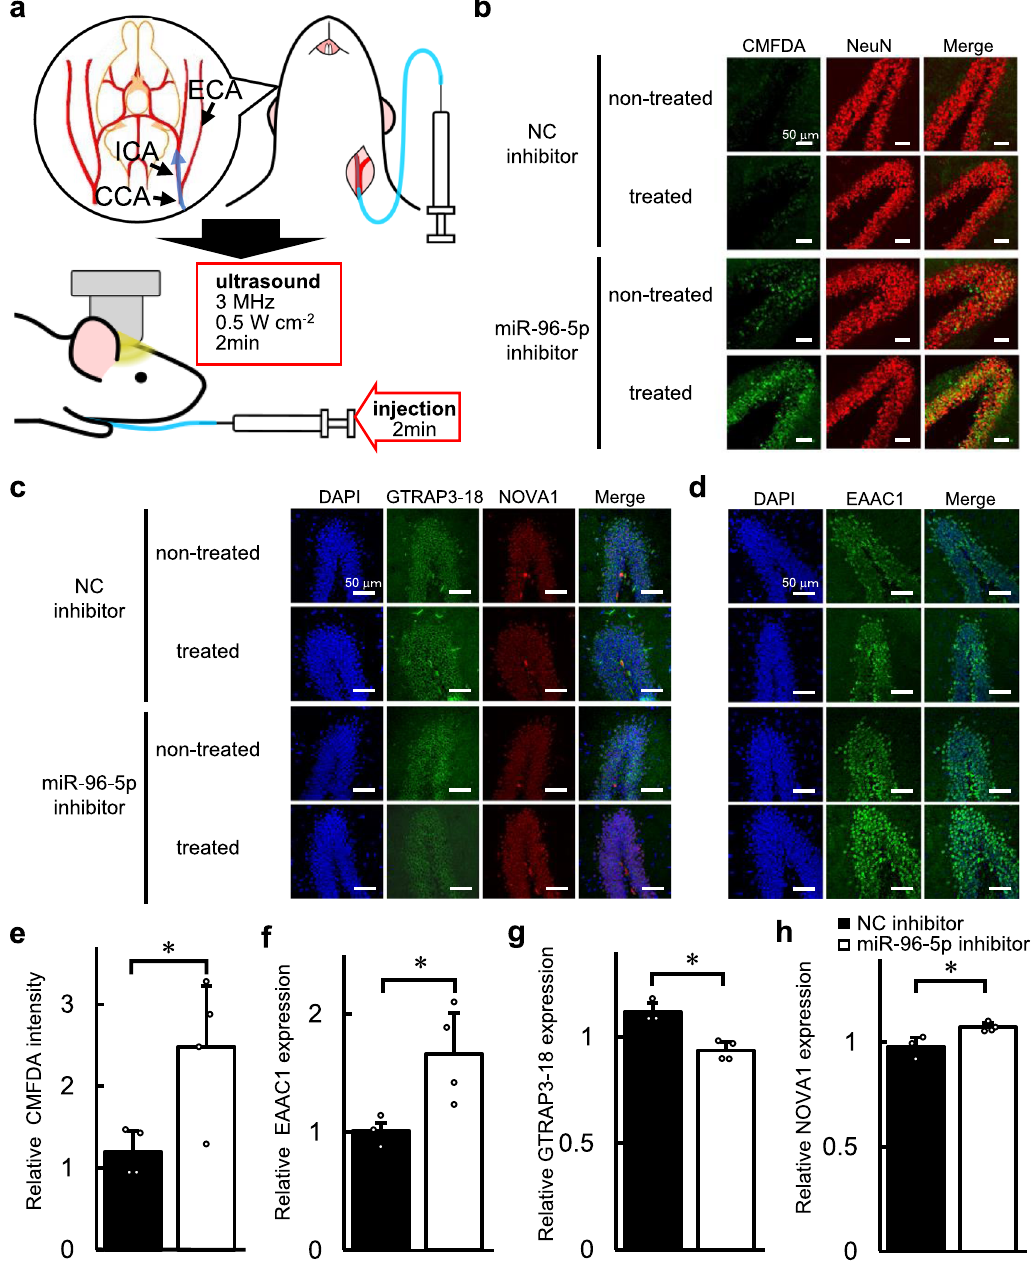
Fig. 5 Effect of the intra-arterial administration of miR-96-5p inhibitor with MBs and US on the levels of GSH, EAAC1, GTRAP3-18, and NOVA1. a A schematic of the intra-arterial (i.a.) injection is shown. The common carotid artery (CCA), external carotid artery (ECA), and internal carotid artery (ICA) are exposed, and a small incision is made on the CCA. The catheter is inserted and advanced towards the ICA; once the catheter is stably positioned, a mixture of miR-96-5p inhibitor and MBs is injected with a programmed microinjector. Simultaneously with the injection, ultrasound (US) is administered from a probe placed on the shaved heads of the mice. b Confocal images show the effect of administration of a miR-96-5p inhibitor or a negative control (NC) inhibitor on the intensity of CMFDA as an intracellular GSH marker (green). NeuN is stained as a neuronal nuclear marker (red) and co-localized with the CMFDA signal. Scale bar, 50 μ m. c Confocal images show the effect of administration of a miR-96-5p inhibitor or an NC inhibitor on the expressions of GTRAP3-18 (green) and NOVA1 (red). The nuclei were stained with DAPI (blue). Scale bar, 50 μ m. d Confocal images show the effect of administration of a miR-96-5p inhibitor or an NC inhibitor on the EAAC1 expression (green). The nuclei were stained with DAPI (blue). Scale bar, 50 μ m. e The level of CMFDA intensity after the administration of NC or miR-96-5p inhibitor are shown. Data are mean values ± SD obtained from four independent experiments and individual data points are plotted. Data were analyzed by Student ’ s t -test, two-sided. * p < 0.05 relative to NC inhibitor. f – h The expression of EAAC1 ( f ), GTRAP3-18 ( g ), and NOVA1 ( h ) after the administration of NC or miR-96-5p inhibitor are shown. Data are mean values ± SD obtained from independent samples ( n = 3 for NC inhibitor, n = 4 for miR-96-5p inhibitor) and individual data points are plotted. Data were analyzed by Student ’ s t -test, two-sided. * p < 0.05 relative to NC inhibitor.